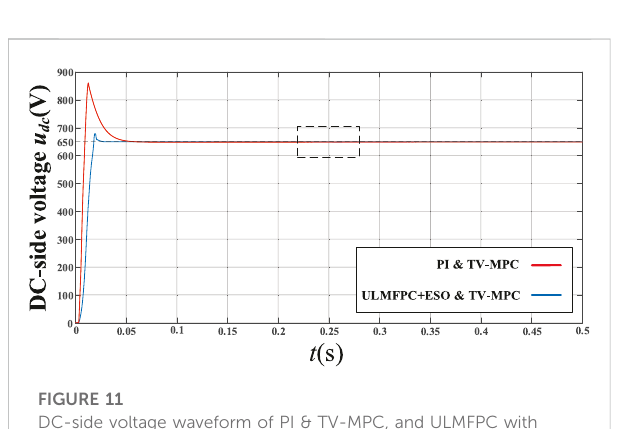
DC-side voltage waveform of PI & TV-MPC, and ULMFPC with ESO &